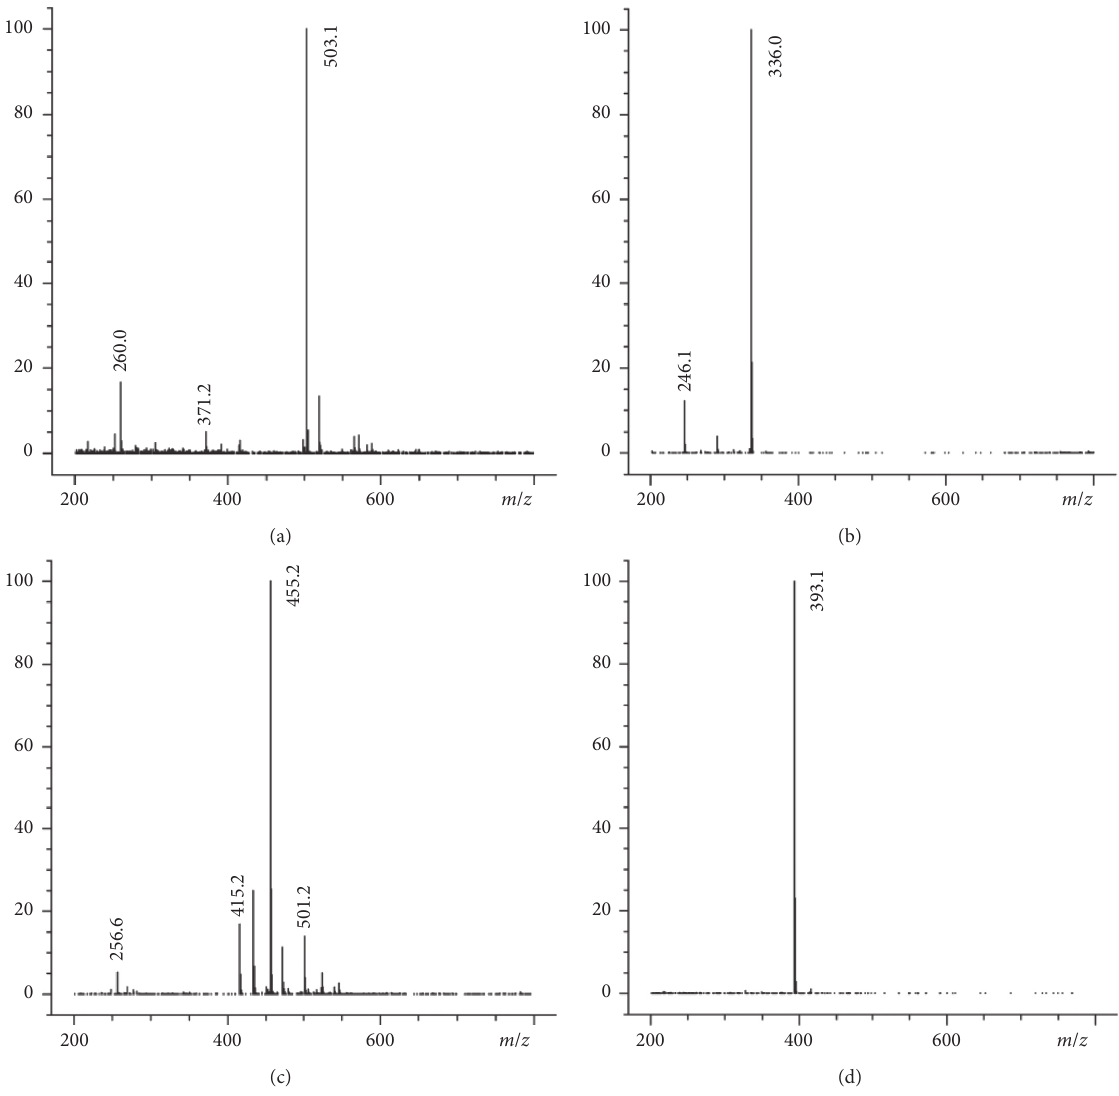
Figure 2: Full scan mass spectra for PF (a), BBR (b), SCH (c), and IS (d).